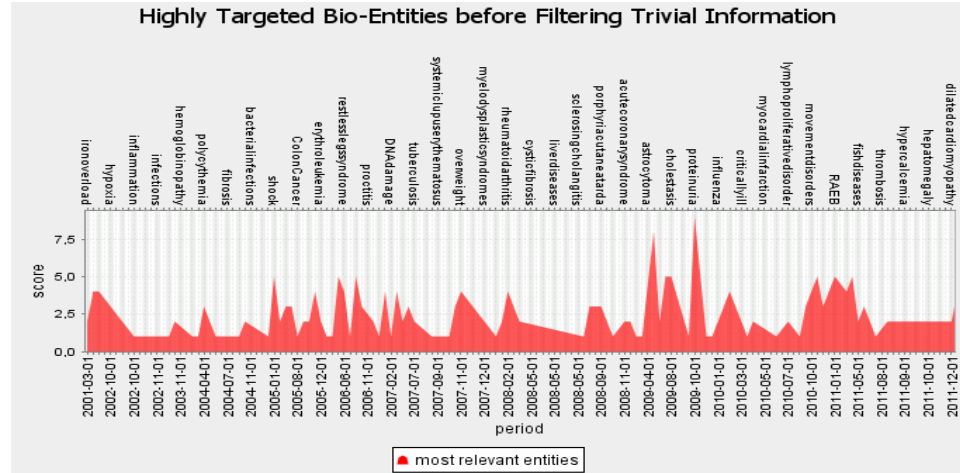
Figure 12. Highly targeted diseases when the background is